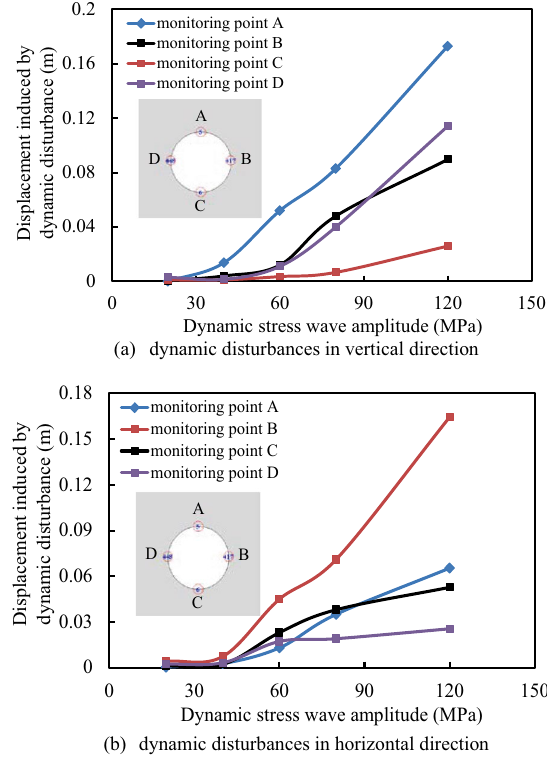
(b) dynamic disturbances in horizontal direction Fig. 15 Displacement distribution for different monitoring points around cavern as functions of stress-wave amplitudes in vertical and horizontal